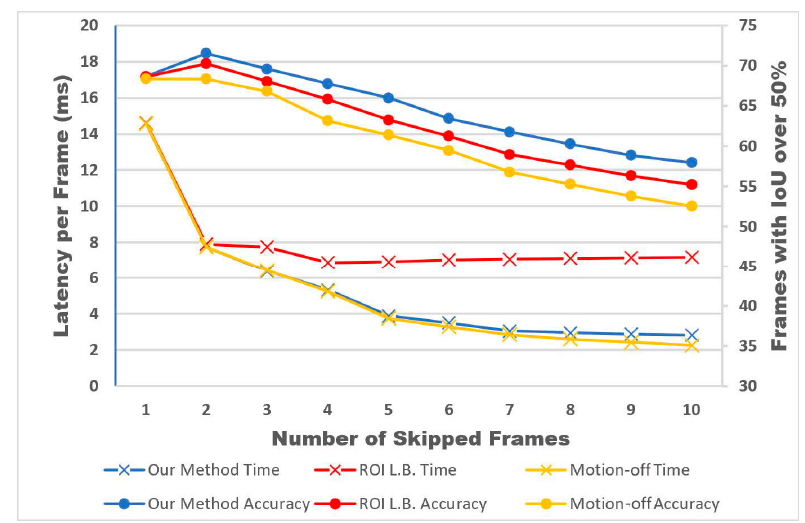
Figure 7. Consolidated performance of LB-based YOLOX.